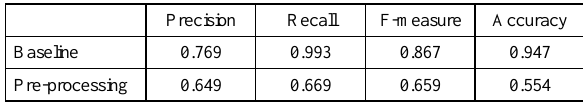
Table 2. Indices of baseline method and pre-processing